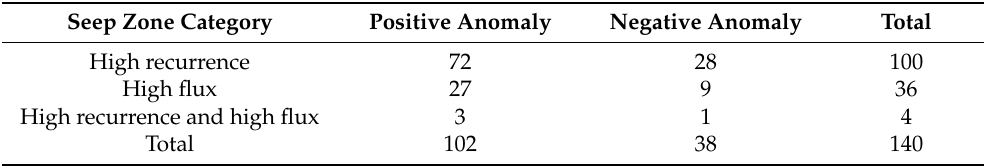
Figure 13. Locations of seep zones exhibiting rates of high flux, high recurrence, and both high flux and recurrence (i.e., 2 SD ≥ mean rate). Table 3. Number of categorized seep zones associated with positive and negative BOEM seismic anomalies. Note that an individual seep zone may be associated with multiple positive and/or negative anomalies, resulting in totals greater than the number of prolific seep zones. Seep Zone Category Positive Anomaly Negative Anomaly